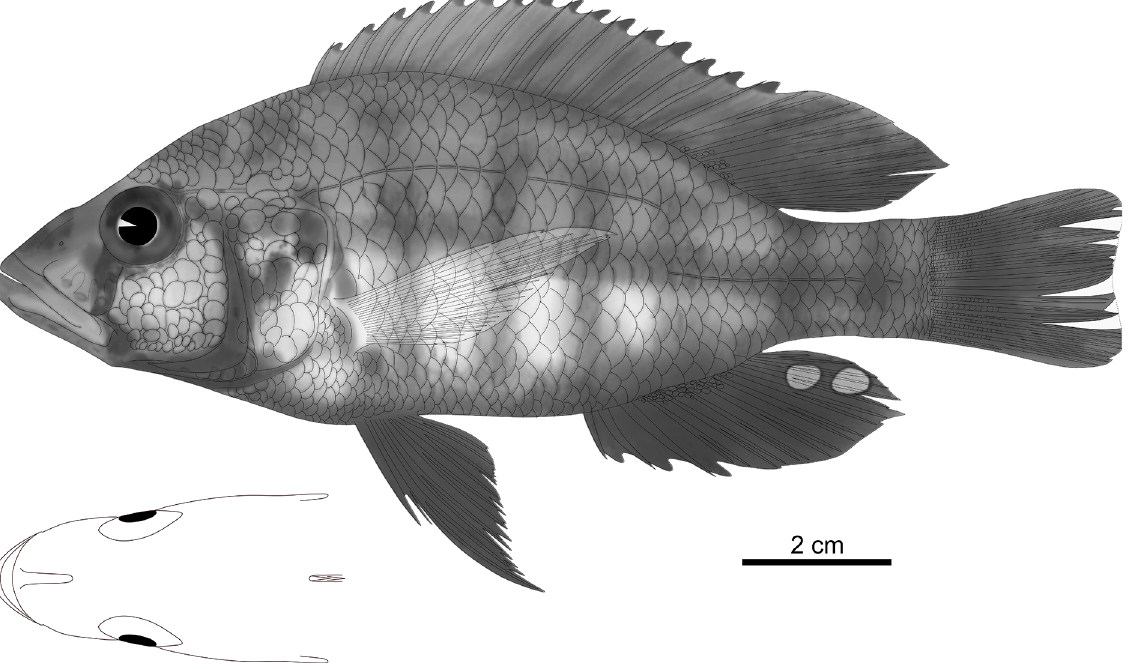
Fig. 35. Haplochromis quasimodo sp. nov., holotype, ♂, 120.4 mm SL (RMCA 2018.008.P.0336). Drawn by N.